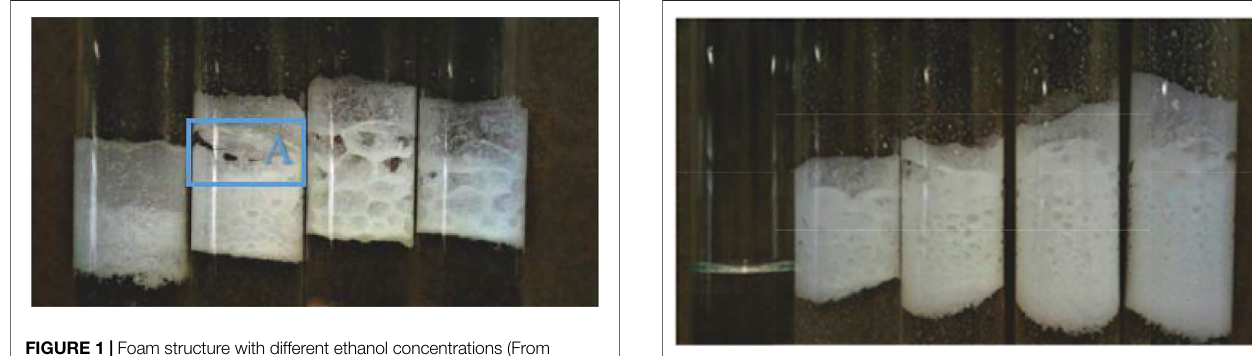
FIGURE 3 | Foam structure with different particle concentrations (From left to right: 0 wt% PTFE, 1.0 wt% PTFE, 2.0 wt% PTFE, 3.0 wt% PTFE,